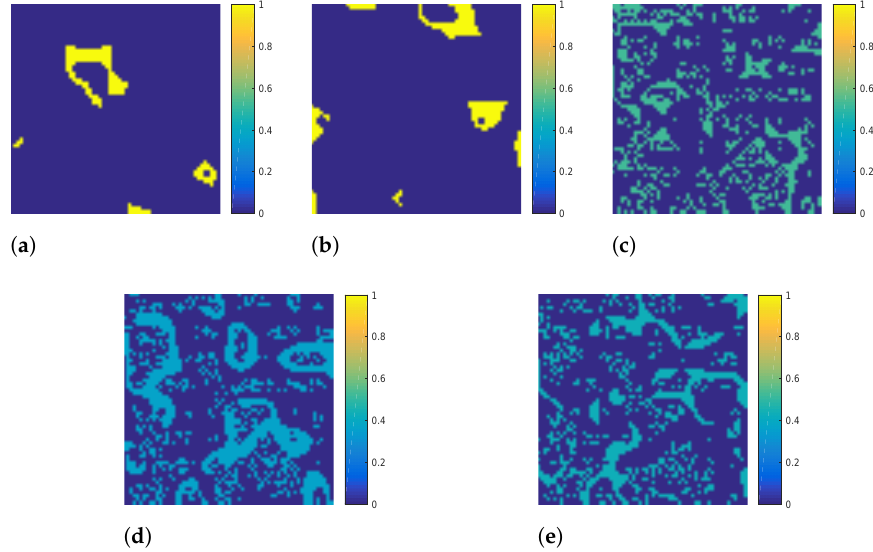
Figure 6. Visual demonstration of the proposed weight matrix. ( a – e ) Visual images of the weight matrix B , where each image is represented by a manner of the heat map, and non-zero pixels in the k -th image has the value of w k